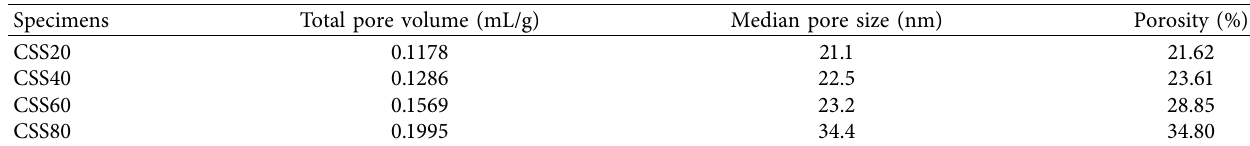
Table 5: Aperture parameters of blended cement paste containing steel slag